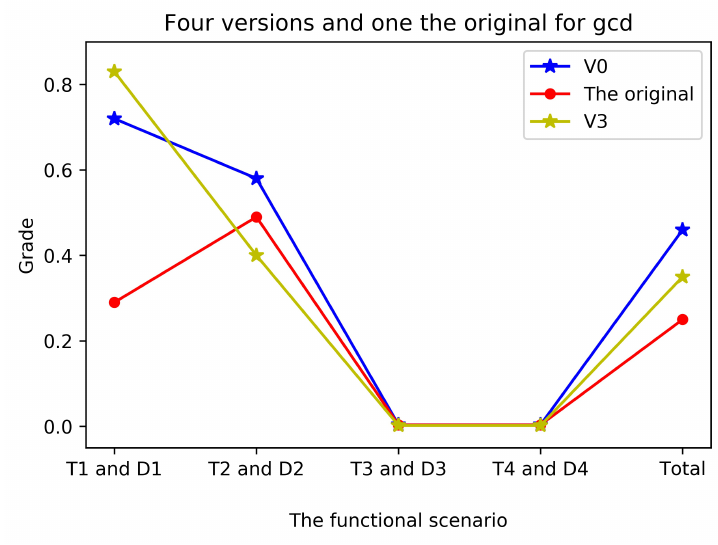
Figure 8. Results by four versions and the original for